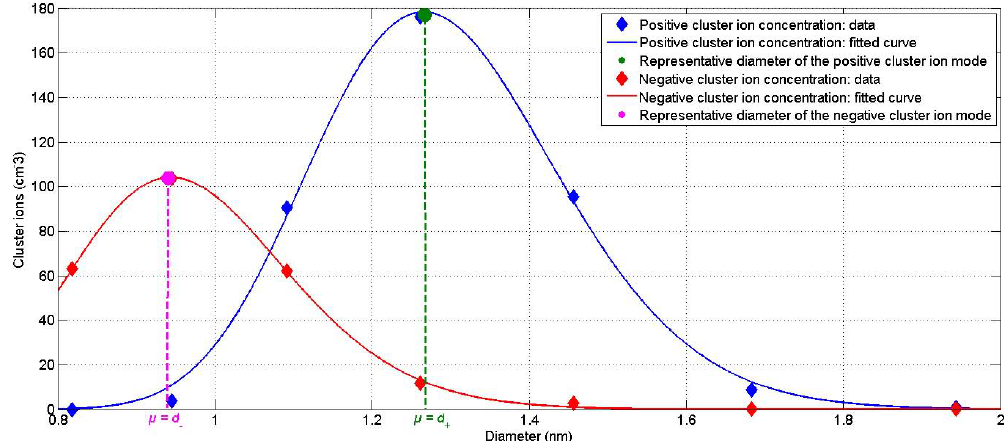
Fig. 5. Determination of the representative diameters of the positive and cluster ion mode ( d + and d − , respectively) by fitting a log-normal distribution to the cluster ion size distribution. d + (respectively d − ) corresponds to the location parameter (usually referred to as “ µ ”) of the corresponding log-normal distribution.